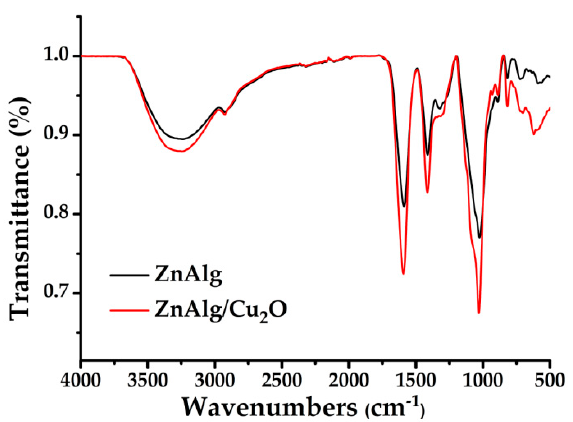
Figure 3. Fourier transform infrared spectrum (FTIR) spectra of ZnAlg and ZnAlg/Cu 2